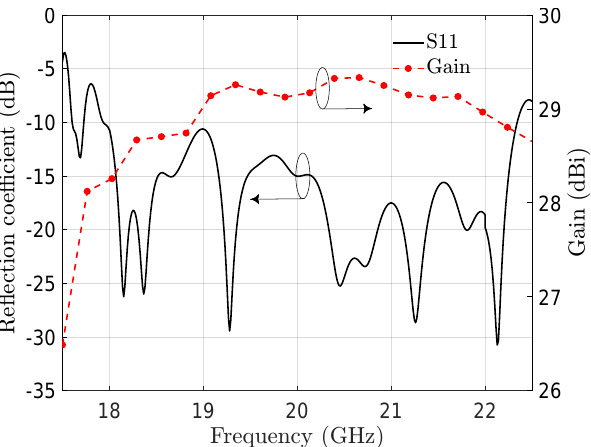
Figure 9. Reflection coefficient (black line) and gain (red line with symbols) for the proposed slotted cavity antenna array.